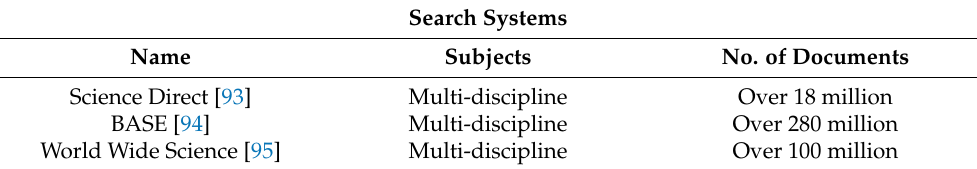
Table 5. Suitable search systems